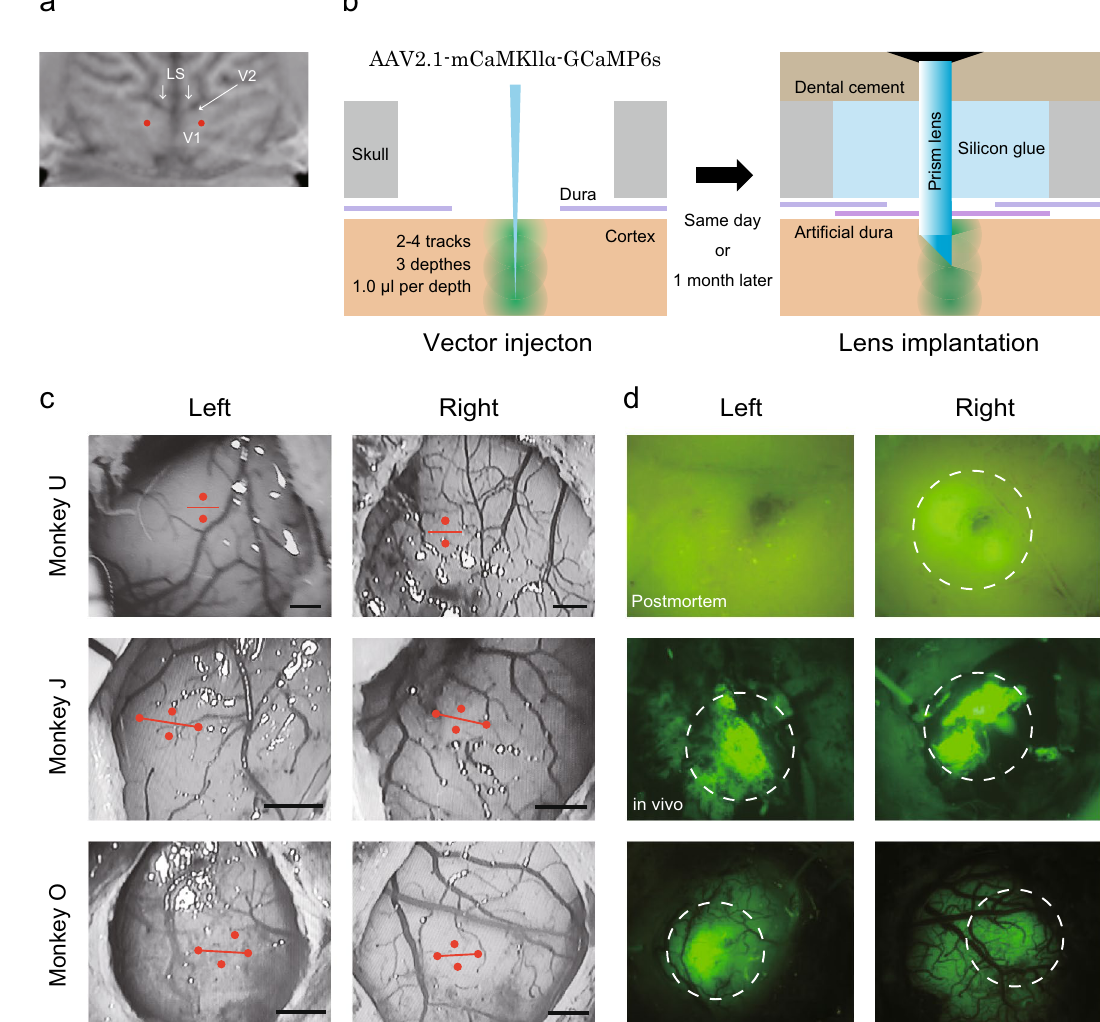
Figure 1. Vector injection sites and fluorescence expression on the cortical surface. ( a ) Representative target positions in the bilateral V1 (red dots). ( b ) Illustration of the virus injection and lens implantation procedures. AAV2.1 vector was injected at three different depths using a glass micropipette. At the same day or a month later, a prism lens was implanted into the location where the virus was injected. ( c ) Micrographs of the cortical surface showing the positions of virus injection and lens insertion in the left and right hemispheres of the three monkeys. Red dots and lines indicate the positions of virus injection and lens insertion, respectively. Scale bar: 1 mm. ( d ) Handheld fluorescent microscopy of virus injection positions postmortem (Monkey U) and in vivo (Monkey J and O). GCaMP expressions observed by the handheld fluorescent microscope were indicated within white dotted circles. LS, lunate sulcus; V1, primary visual cortex; V2, secondary visual